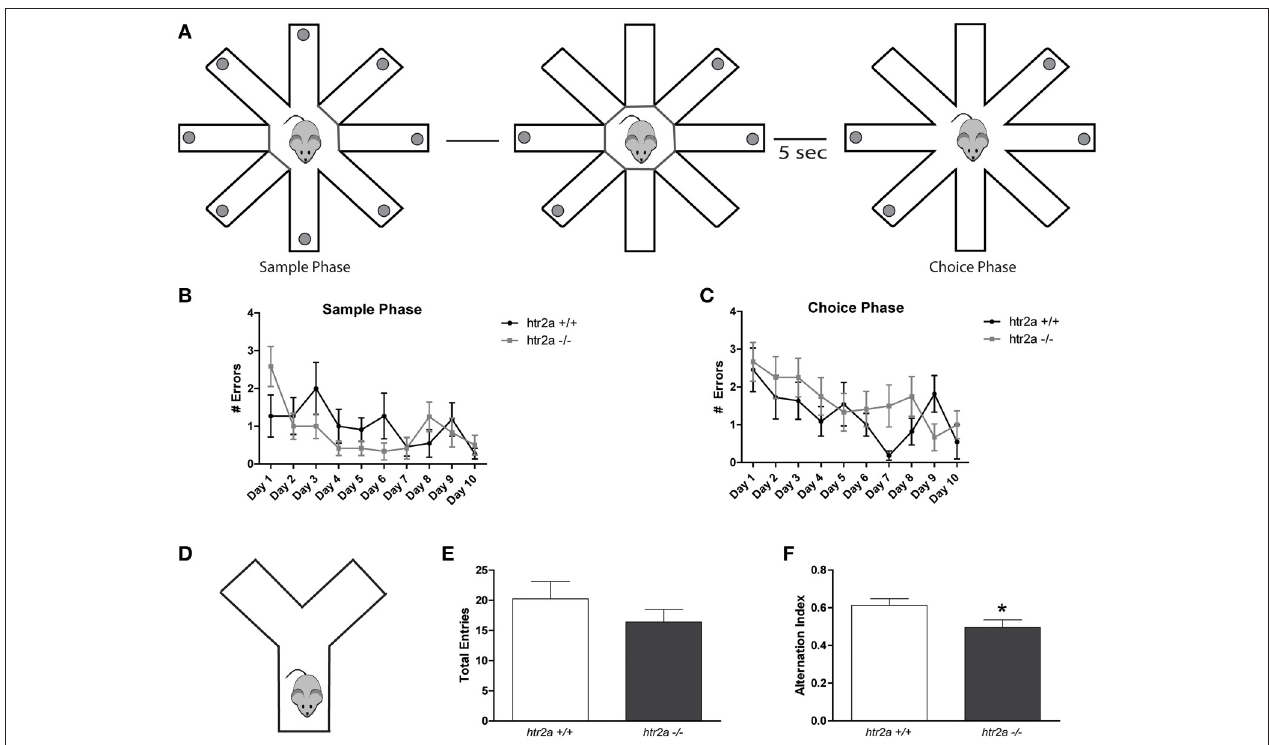
FIGURE 4 | Serotoninergic modulation via 5-HT2AR is required for the resolution of working memory tasks with high level of interference. (A) Training and test scheme for the Radial Arm Maze test. Food-deprived mice were exposed to a single trial per day during 10 days. The delay between sample and choice phase was 5s. (B) Number of errors made during sample phase. (C) Number of errors made during choice phase. n = 10 per group, p > 0.2 , Two-way ANOVA. (D) Scheme of the Y-maze employed. Animals were located at the end of one of the tree arms and were allowed to explore the maze for 8min. (E) Total number of entries to the Y-maze arms. (F) Alternation index made by the mice during the Y-maze spontaneous alternation test. n = 12 per group, * p < 0.05 , Student’s t